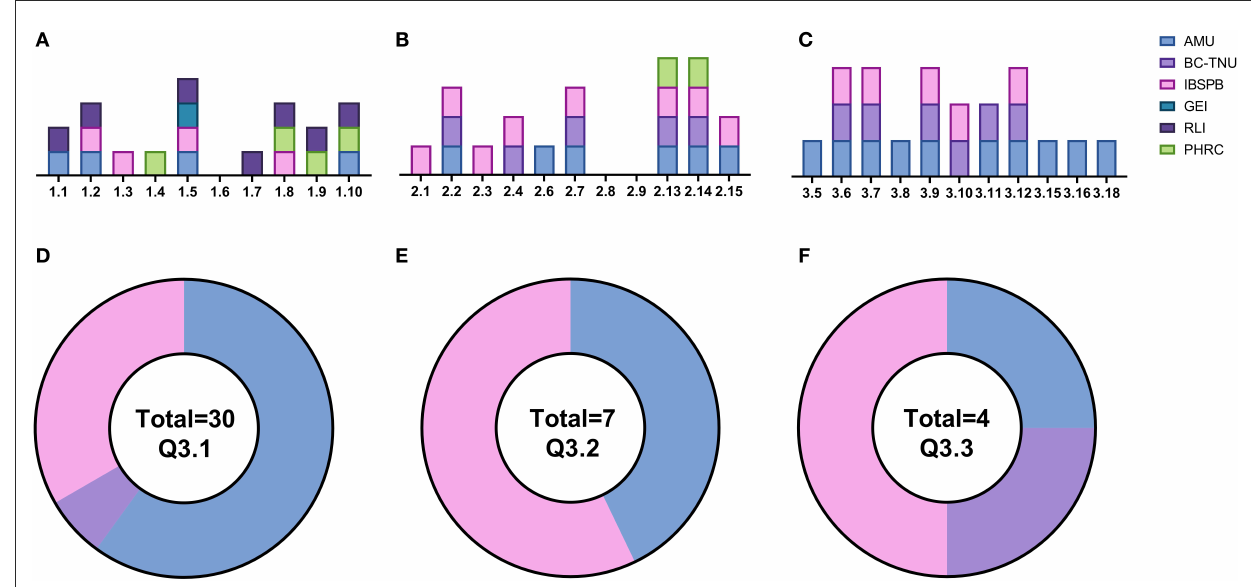
FIGURE1 Summary of questionnaire responses. (A) Section 1: institutional/organizational expertise. (B) Section 2: laboratory infrastructure and personnel. (C) Section 3: technical expertise. (D) Distribution of fridges. (E) Distribution of − 20 ◦ C freezers. (F) Distribution of − 80 ◦ C freezers. AMU (blue): Azerbaijan Medical University (Azerbaijan), BC-TNU (mauve): Biotechnology Center-Tajik National University (Tajikistan), IBSPB (pink) = Institute of Biological Safety Problems and Biotechnology (Tajikistan), GEI (teal): George Eliava Institute (Georgia), RLI (purple): Richard Lugar Institute (Georgia), PHRC (green): Public Health and Reform Center